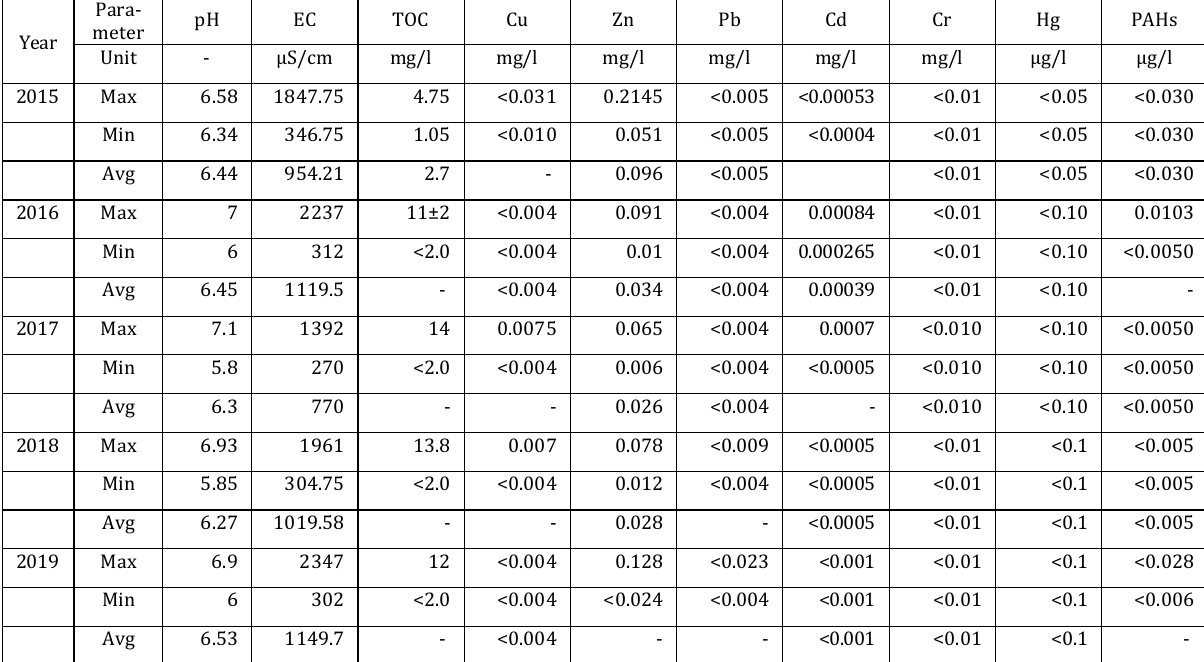
Table 5. LWPI values in piezometers monitoring the Quaternary aquifer in the years 2015-2019